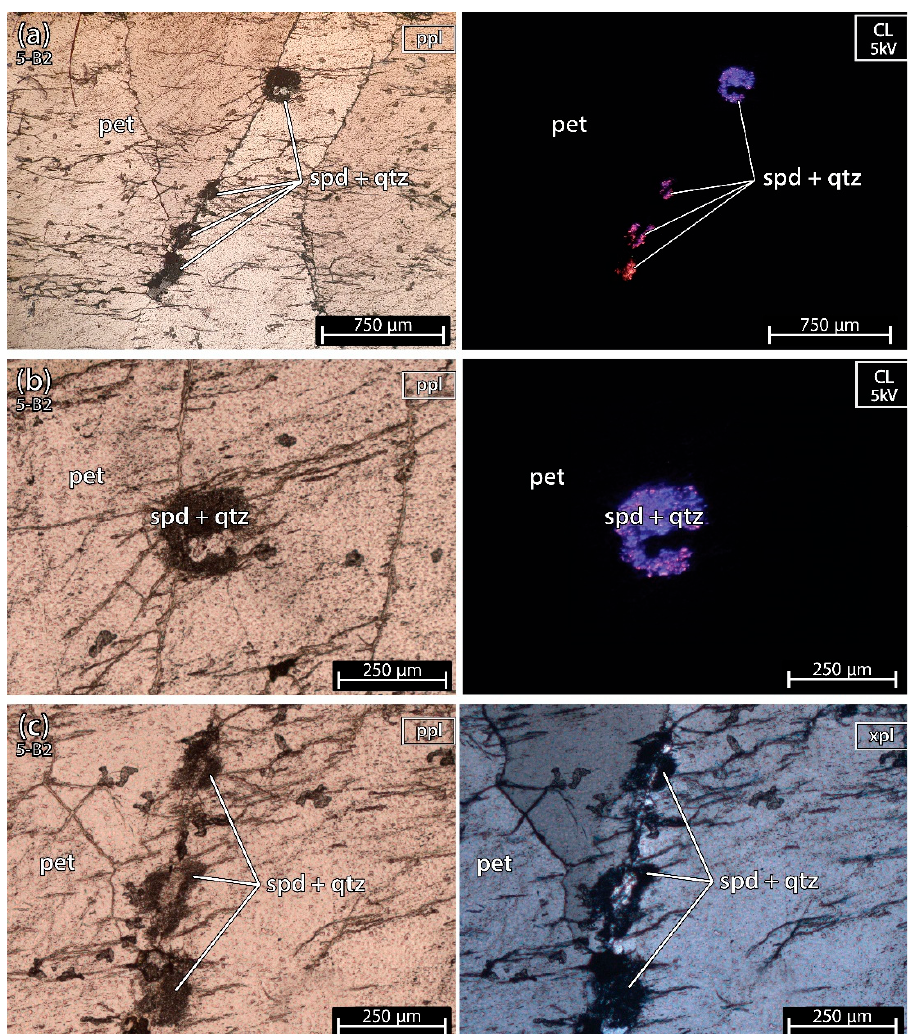
Figure 6. Microphotographs in parallel polarized light (ppl), crossed polarized light (xpl) and cold cathodoluminescence (CL) microscopy (CL) from a petalite (pet) fragment of the crystal sample 1 of the aplite-pegmatite 38 (38-B1). ( a – c ) spodumene + quartz in a fracture of petalite. In CL, the color of spodumene varies from bright purple to orange, while petalite and quartz look almost black next to spodumene observed at 5–6 kV.